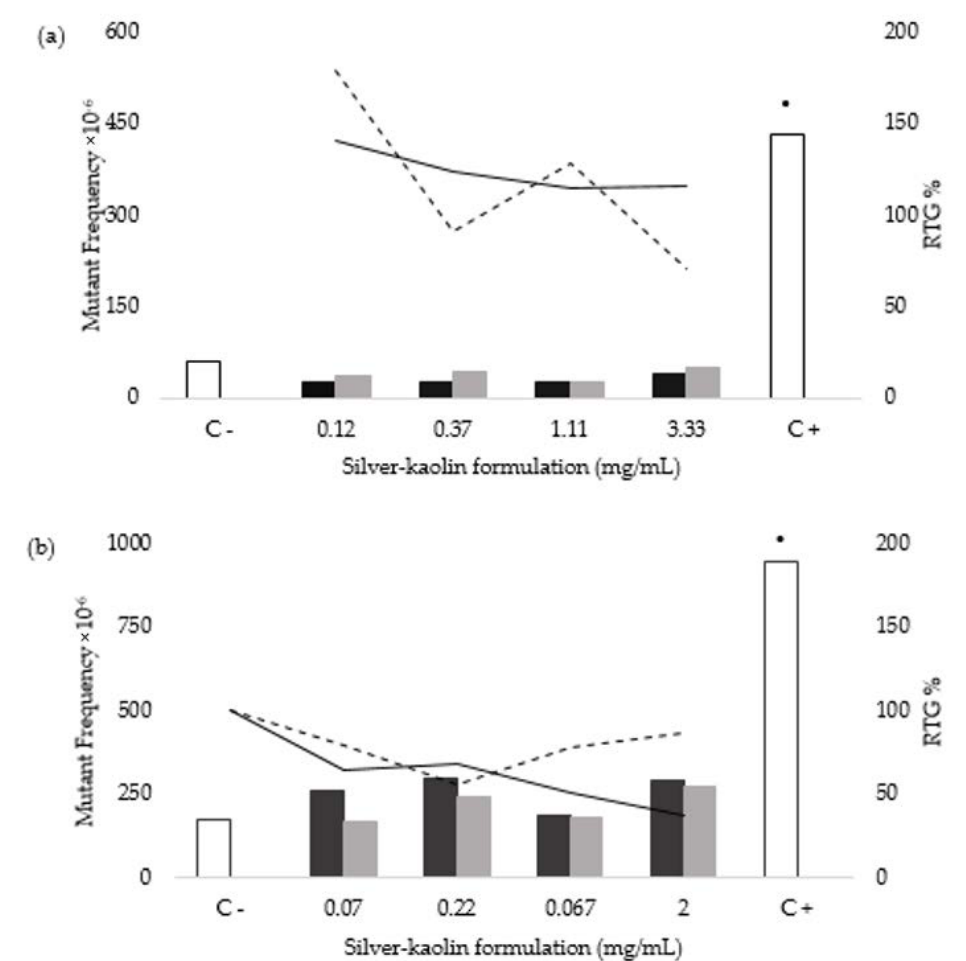
Figure 3. Results of the MLA after 3 h ( a ) and 24 h ( b ) treatment of L5178Y TK+/ − cells. Each figure shows the induction of gene mutations, represented as mutant frequency × 10 − 6 , by silver-kaolin formulation (black bars), its corresponding silver-kaolin release (grey bars), and for the negative (C − ) and positive controls (C+) (white bars with black edge). It also shows the cytotoxicity of silver-kaolin formulation (continuous line) and its corresponding silver-kaolin release (dotted line), represented as % RTG values compared to the negative control for each testing condition. C+: cells treated with 100 µ M MMS. • : difference from negative control based on OECD TG 490 global evaluation factor